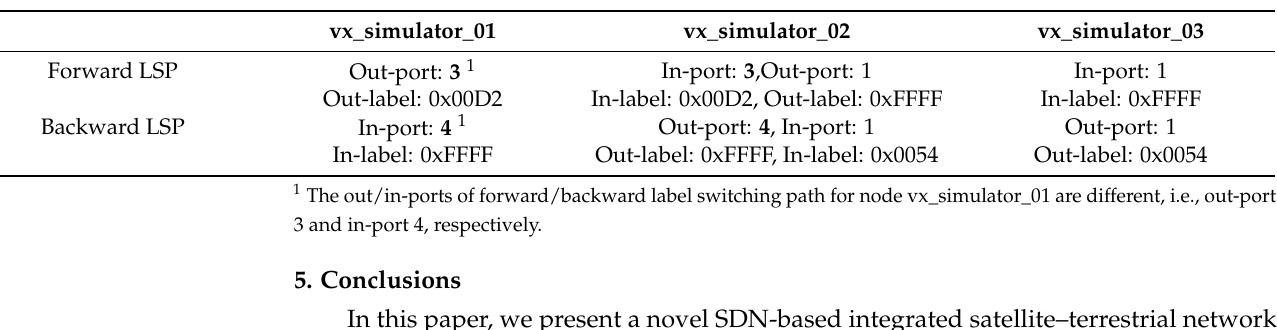
Table 6. The bi-directional label switching path under QoS requirements and the circumstances of uni- directional link between node vx_simulator_01 and node vx_simulator_03 in the semi-physical